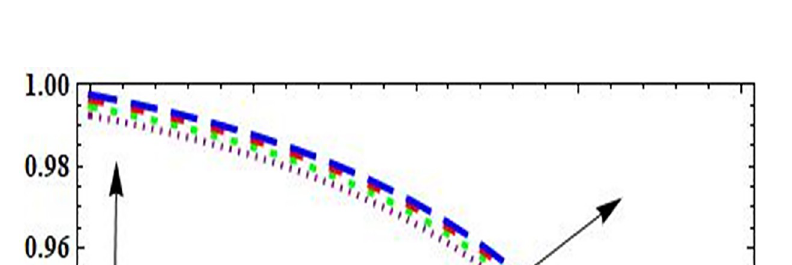
¼ 0 : 6 ; L ¼ L ¼ 0 : 2 ; M ¼ 2 : 0 ; Q ¼ 0 : 1 = . 2 2 1